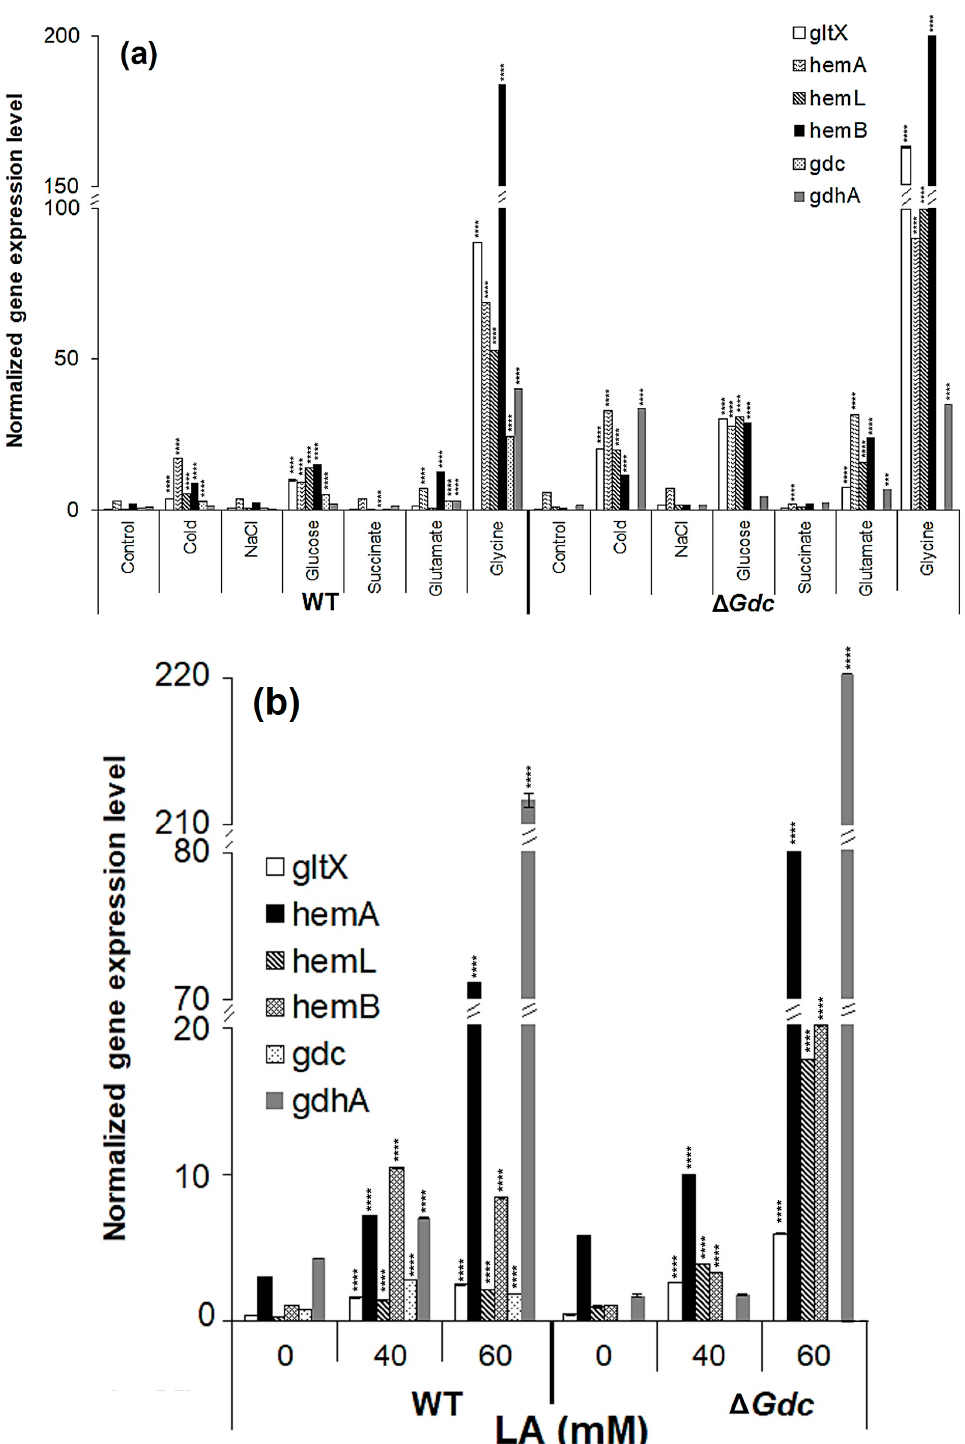
Figure 5. Transcriptional regulation of pathway genes in the Synechocystis wild-type (WT) and the Gdc knockout mutant ( ∆ Gdc ) strains. Analysis of the gene expression profile of various genes related to δ -aminolevulinic acid (ALA) and glutamate metabolism in Synechocystis sp. PCC6803 (WT) and the ∆ Gdc strain grown under ( a ) various treatments and ( b ) different concentrations of levulinic acid (LA). Results were normalised to 16S rRNA levels and bars represent the mean ± standard errors of three independent real-time RT-PCR reactions. If the error bar cannot be seen, the deviation is very small. *** p < 0.01, **** p < 0.001 versus untreated group. The respective gene IDs and the descriptions of the targeted genes are provided in Table 1 and Figure 1. Table 1. Oligonucleotides used in this study and their relative IDs as registered in the Cyanobase (http://genome.microbedb.jp/cyanobase/GCA_000009725.1 (accessed on 07 April, 2022)); restriction sites are underlined.